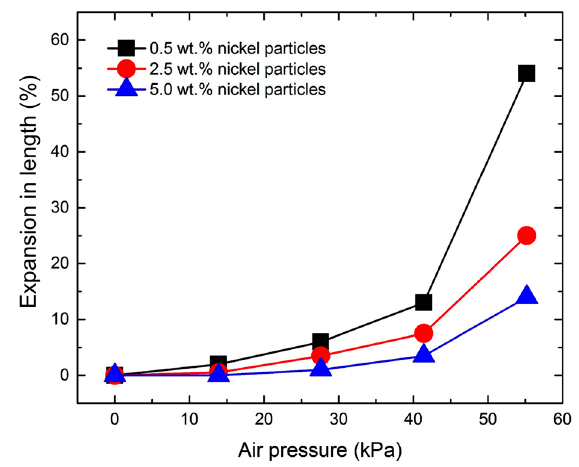
Figure 10. Normalized length expansion of soft bending actuator as a function of applied air pressure.